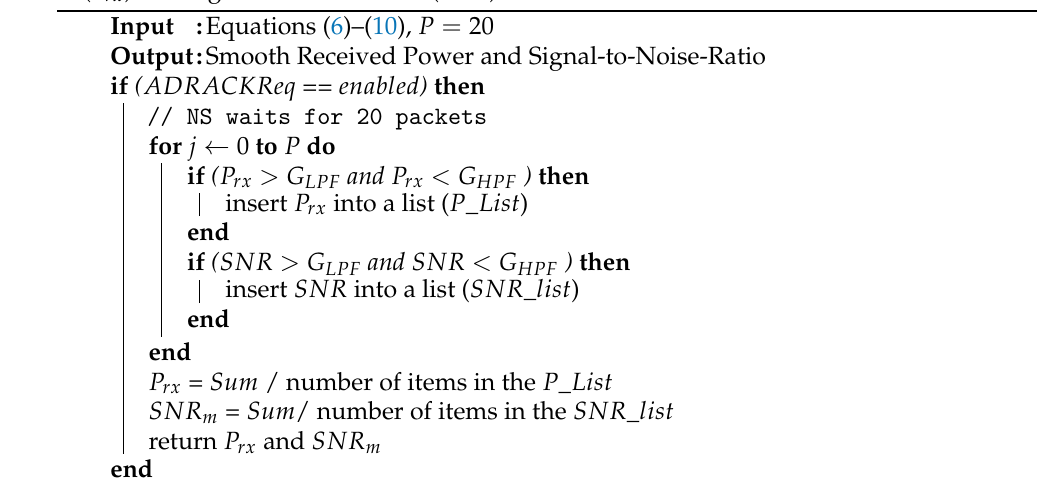
Algorithm 1: The Network Server Proposed ADR to Smooth the Received Power